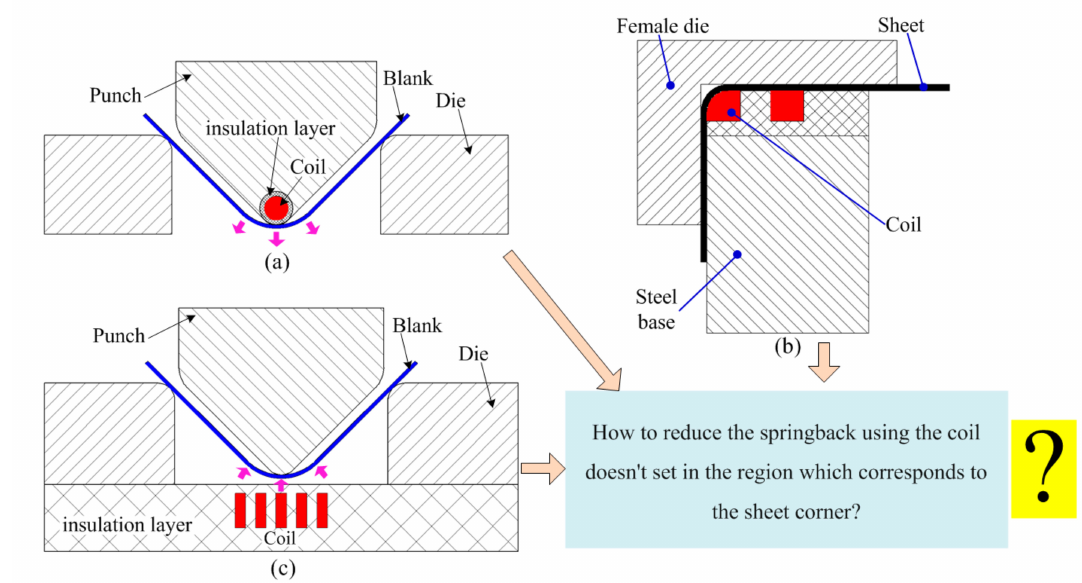
Figure 1. Existing springback reduction methods using magnetic pulse forming: ( a ) V-shaped part using the coil embedded in the punch, ( b ) L-shaped part, ( c ) V-shaped part using inverse magnetic